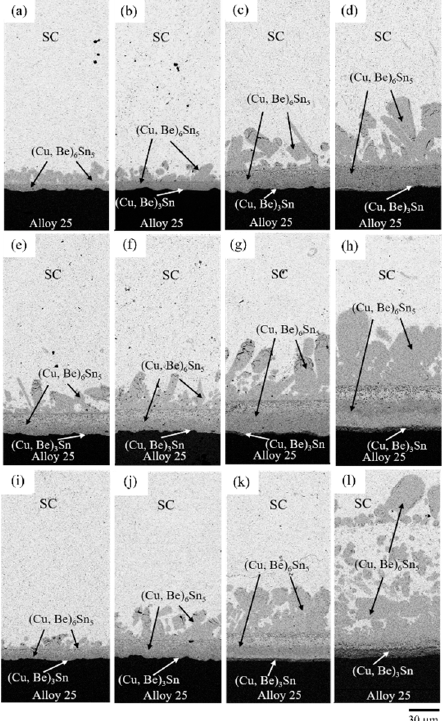
7 of 17 Figure 3. EPMA line scan and corresponding BEI micrograph of SC/C194 reaction couple at a reac- tion temperature of 240 °C and reaction time of 5 h. 3.2. SC/Alloy 25 Reaction Couples The BEI micrograph of the SC/Alloy 25 reaction couple reacted at a 240 °C reaction temperature for a 0.5 h reaction time is shown in Figure 4a. It was found that a dense layered IMC was formed on the substrate side, with a composition of Cu-46.6 at.% Sn-0.8 at.% Be, denoted as (Cu, Be) 6 Sn 5 . It reflected the incorporation of a small amount of Be into the Cu sublattice of the Cu 6 Sn 5 phase, as shown in the previous literature [15]. The BEI micrograph of the reaction couple of SC/Alloy 25 reacted at a 240 °C reaction temperature for a 1 h reaction time is shown in Figure 4b. As the reaction time reached 1 h, a very thin layer with composition Cu-25.4 at.% Sn-4.9 at.% Be was formed, as shown in Figure 4b. According to the Sn-Cu phase diagram [21], the IMC was determined to be the (Cu, Be) 3 Sn